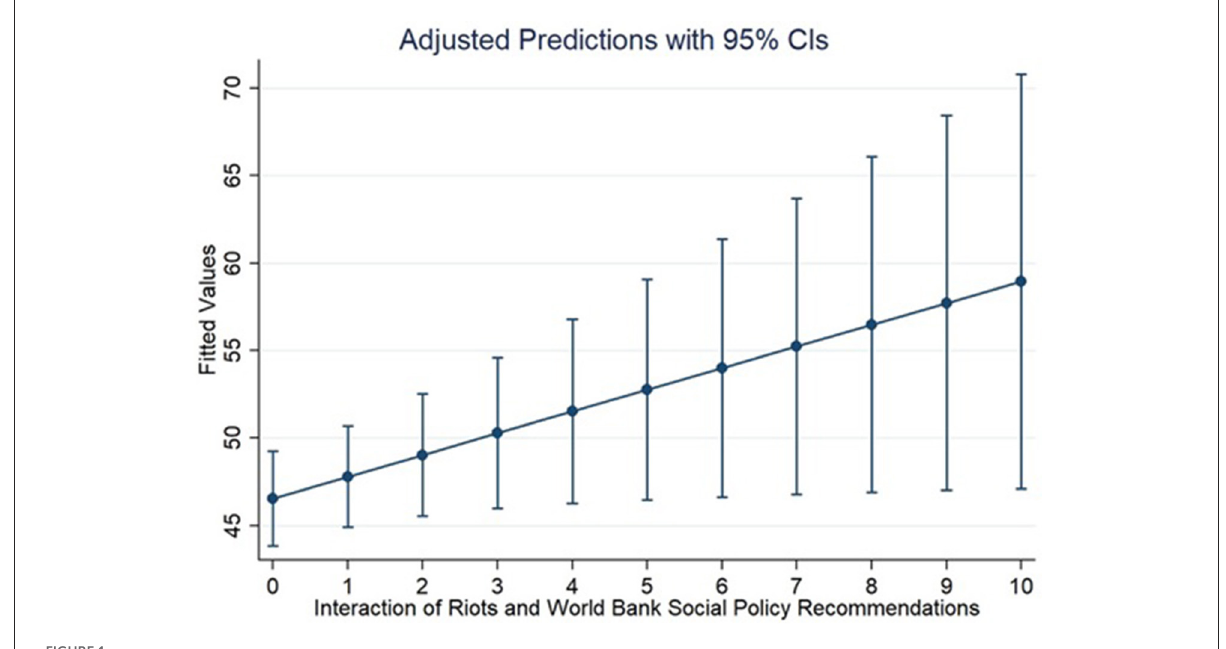
FIGURE1 Average marginal effect with a 95% confidence